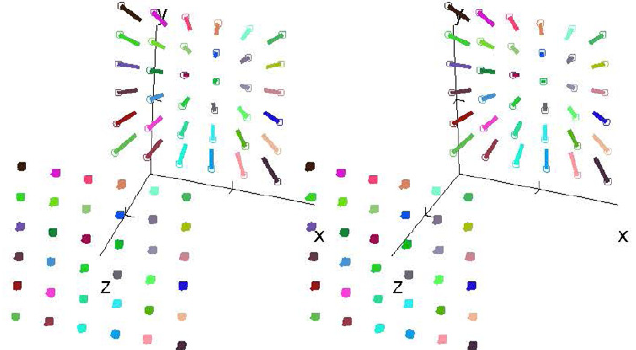
Figure 6. Interpretation of light rays traversing the cornea of Subject 1. ( a ) The 25 coloured dots represent the incident rays in the entrance plane and the corresponding emergent rays are represented with the same colours but by circles with bars. The optical axis is marked with a cross. The optical axis itself rep- resents any ray through the system that is not deviated. So, any ray can serve as an optical axis. The last row and last column of  T indicate that the system is centred. F 0 is the corneal plane refraction and is very large indicating that rays converge mark- edly when passing through the entrance plane or anterior corneal surface.. The power of the cornea is represented by F . All light rays converge toward the optical axis as shown with coloured open circles and bars in the exit plane. ( b ) Stereo-pair scatter plot of the ray vectors in three-dimensions. The z-axis represents the optical axis and the separation between the entrance and exit planes is exaggerated for ease of inspection.